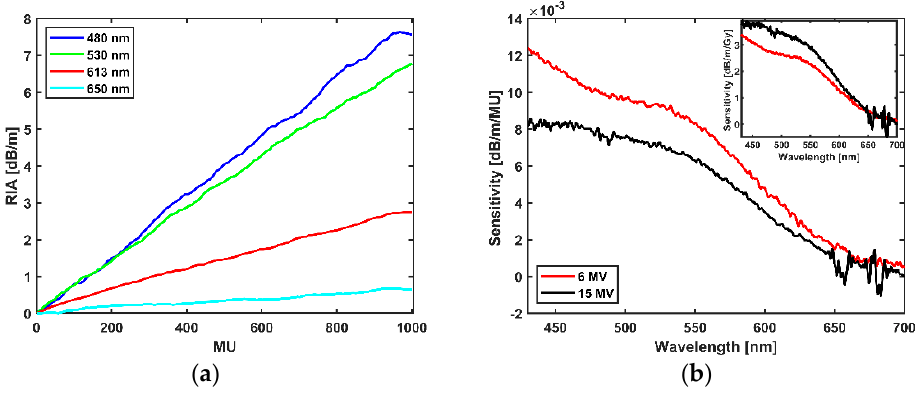
Figure 4. ( a ) Dependence of the RIA on dose (MU) for 15 MV X-ray radiation. ( b ) Sensitivity of the fibre across wavelengths for 6 MV and 15 MV radiation for 1000 MU with inset showing the graph of the conversion to the estimated dose delivered at 100 cm from the source.